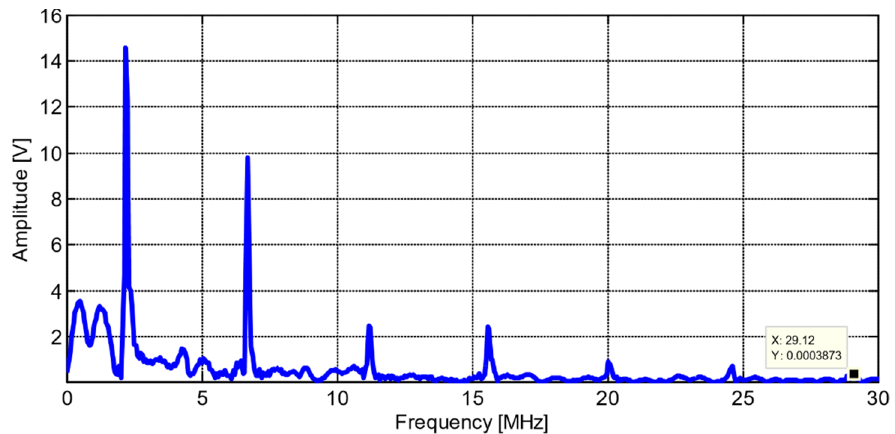
Figure 12. Fast Fourier Transform (FFT) of A-scan collected directly after insertion of bismuth titanate (BiTi) into the reactor [14].